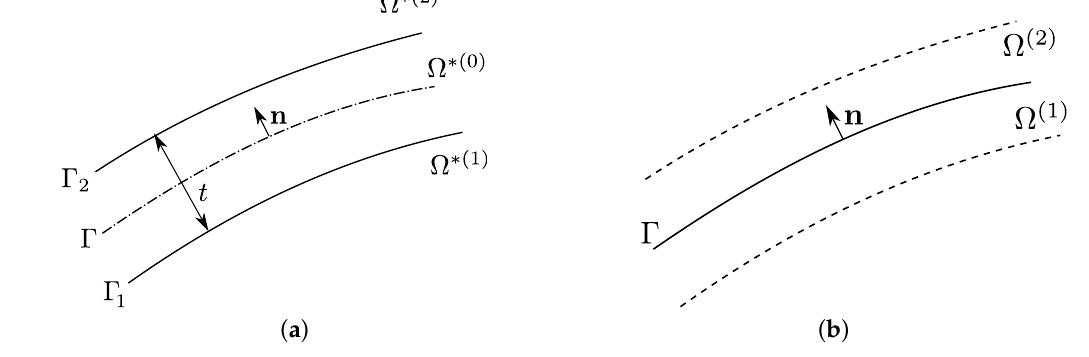
Figure 2. Three-phase ( a ) and two-phase ( b )